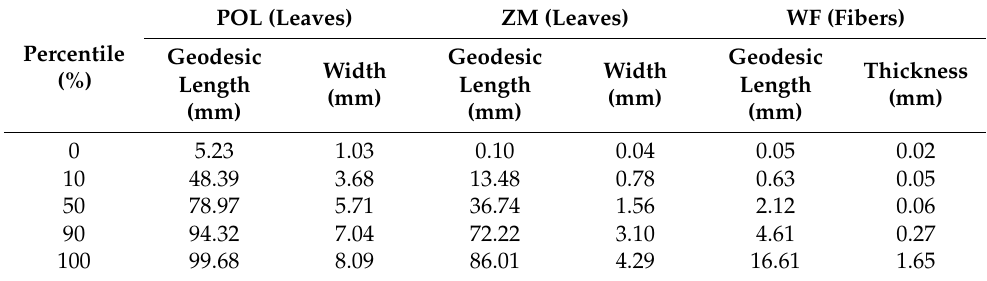
Table 2. Geodesic length and thickness distribution of seagrass Zostera marina (ZM), seagrass Posidonia oceanica (POL), and wood fibers (WF).